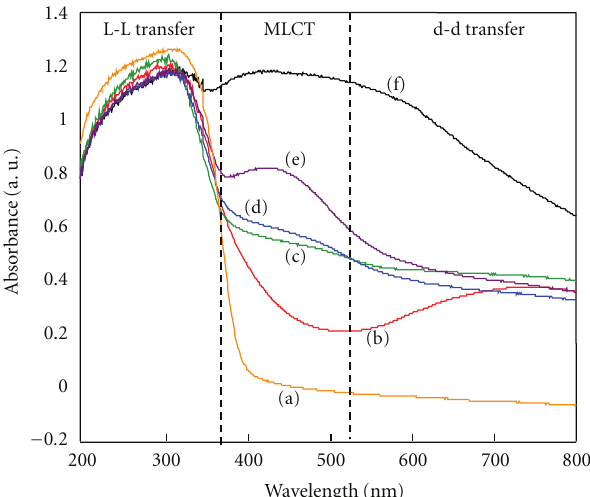
Figure 5: The UV-visible spectra of six photocatalysts as-synthesized. (a) TiO 2 , b) Cu(0.1)-Ti(0.9)O 2 , (c) Cu(0.07)-Ag(0.03)Ti(0.9)O 2 , (d) Cu(0.05)-Ag(0.05)Ti(0.9)O 2 , (e) Cu(0.03)-Ag(0.07)Ti(0.9)O 2 , and (f) Ag(0.1)-Ti(0.9)O 2 .